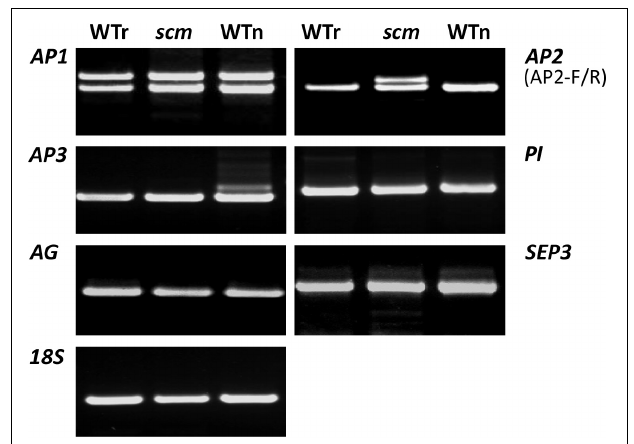
FIGURE 2 | Expression of ABCE classic genes in the scm mutant and wild-type Brassica. WTr, wild-type B. rapa ; WTn, wild-type B. napus ; scm , sepal carpeloid mutant of Brassica